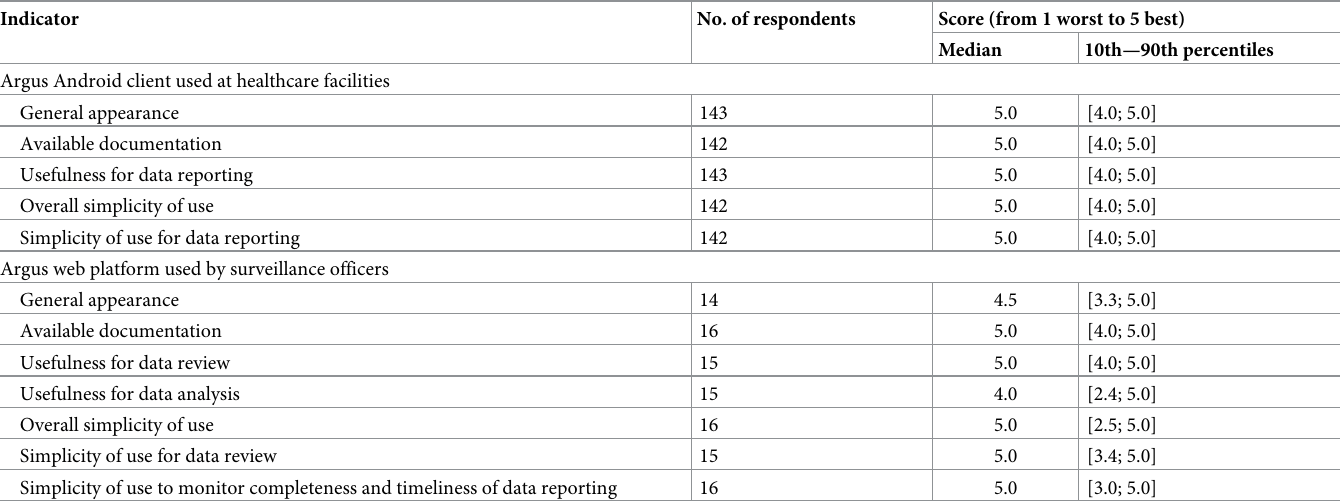
Table 3. Results of the evaluation